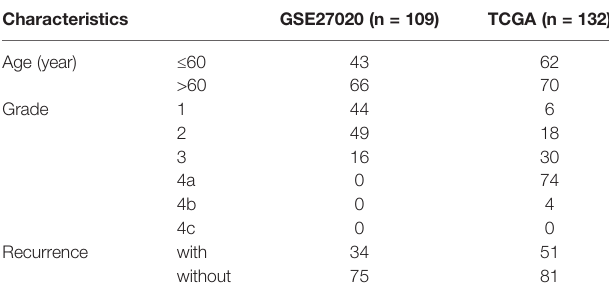
TABLE 1 | Clinical characteristics of laryngeal cancer in the two